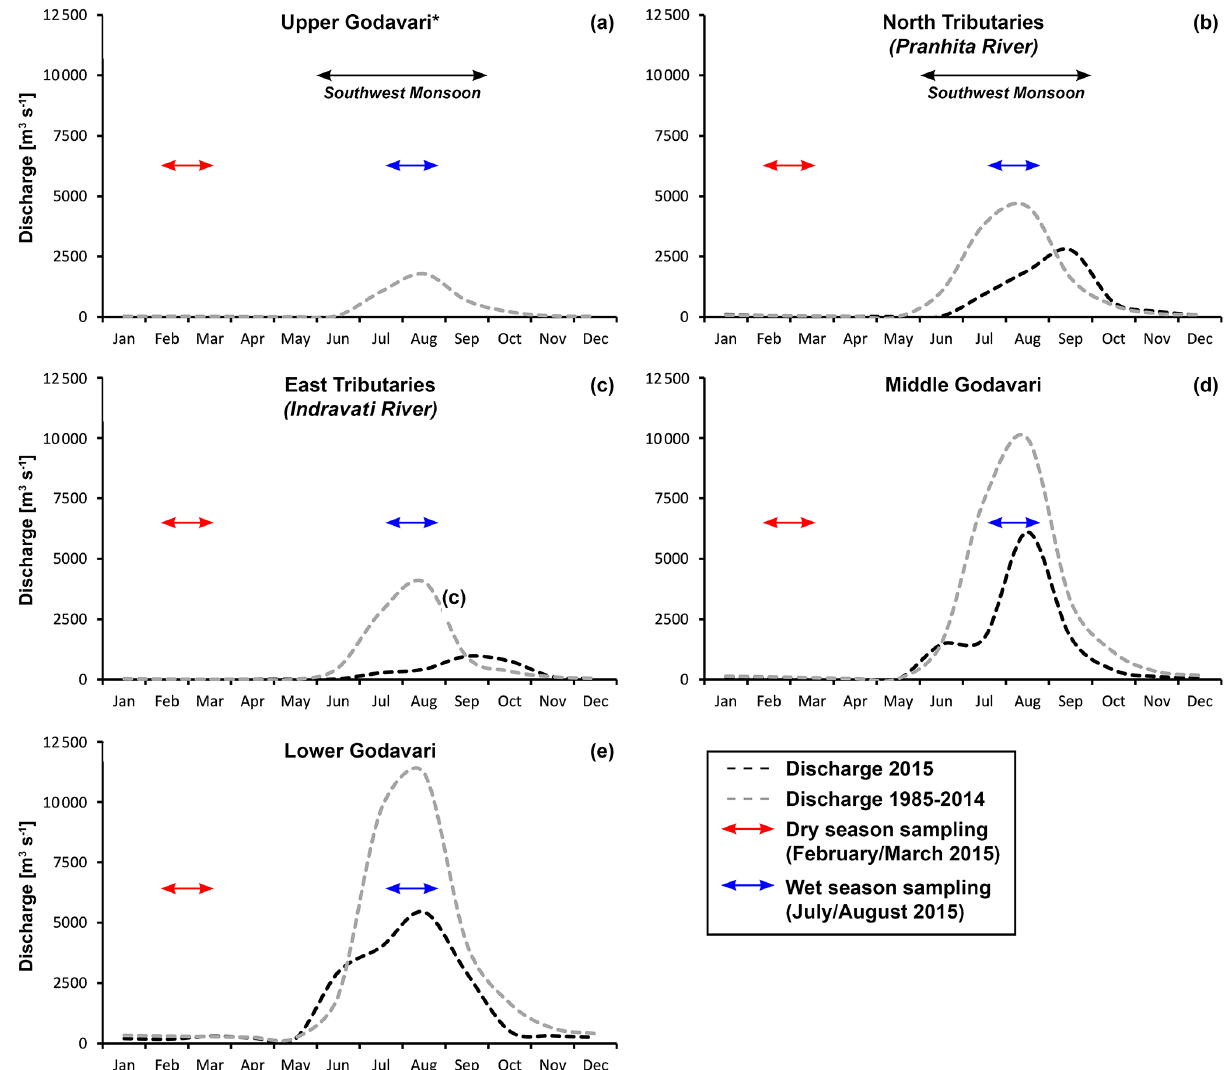
Figure A1. Monthly water discharge data for 2015 and the long-term average for 1985–2014 (India Water Resources Information Sys- tem, 2021) for the Godavari subbasins, (a) upper Godavari (main stem, station at Mancherial, near site 31; ∗ no data are available for April–December 2015), (b) north tributaries (Pranhita River, station at Tekra, near site 32), (c) east tributaries (Indravati River, station at Pathagudem, near site 26), (d) middle Godavari (main stem, station at Perur, ∼ 100km upstream of site 28), and (e) lower Godavari (main stem, station at Polavaram, near site 13 (inflow of the reservoir lake at Rajahmundry)). The arrows indicate the period of sample collection in the dry season (red; February/March 2015) and in the wet season (blue; July/August 2015). The southwest monsoon (SWM) brings the ma- jority of rainfall (75%–85%) in the period June–September. For rainfall distributions across the Godavari basin and variability in southwest monsoon precipitation, see Kirkels et al.